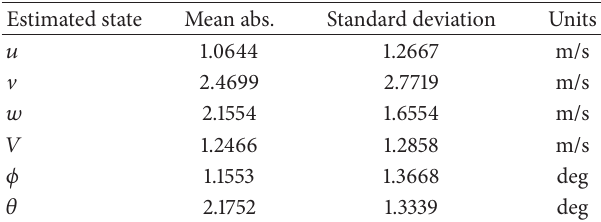
Figure 9: Roll and pitch estimation errors as compared to dead reckoning (DR) for Flight #2. Table 2: Flight #1 error statistics for estimated